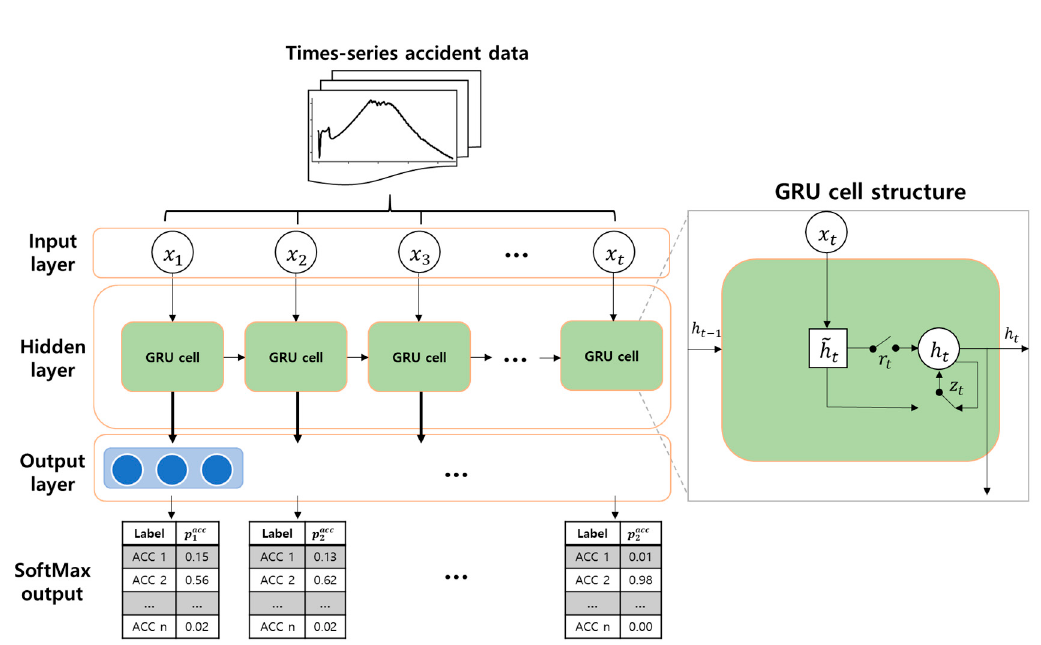
Figure 3. Gated recurrent unit (GRU)-based accident diagnosis algorithm with multivariate time-series input and SoftMax output.